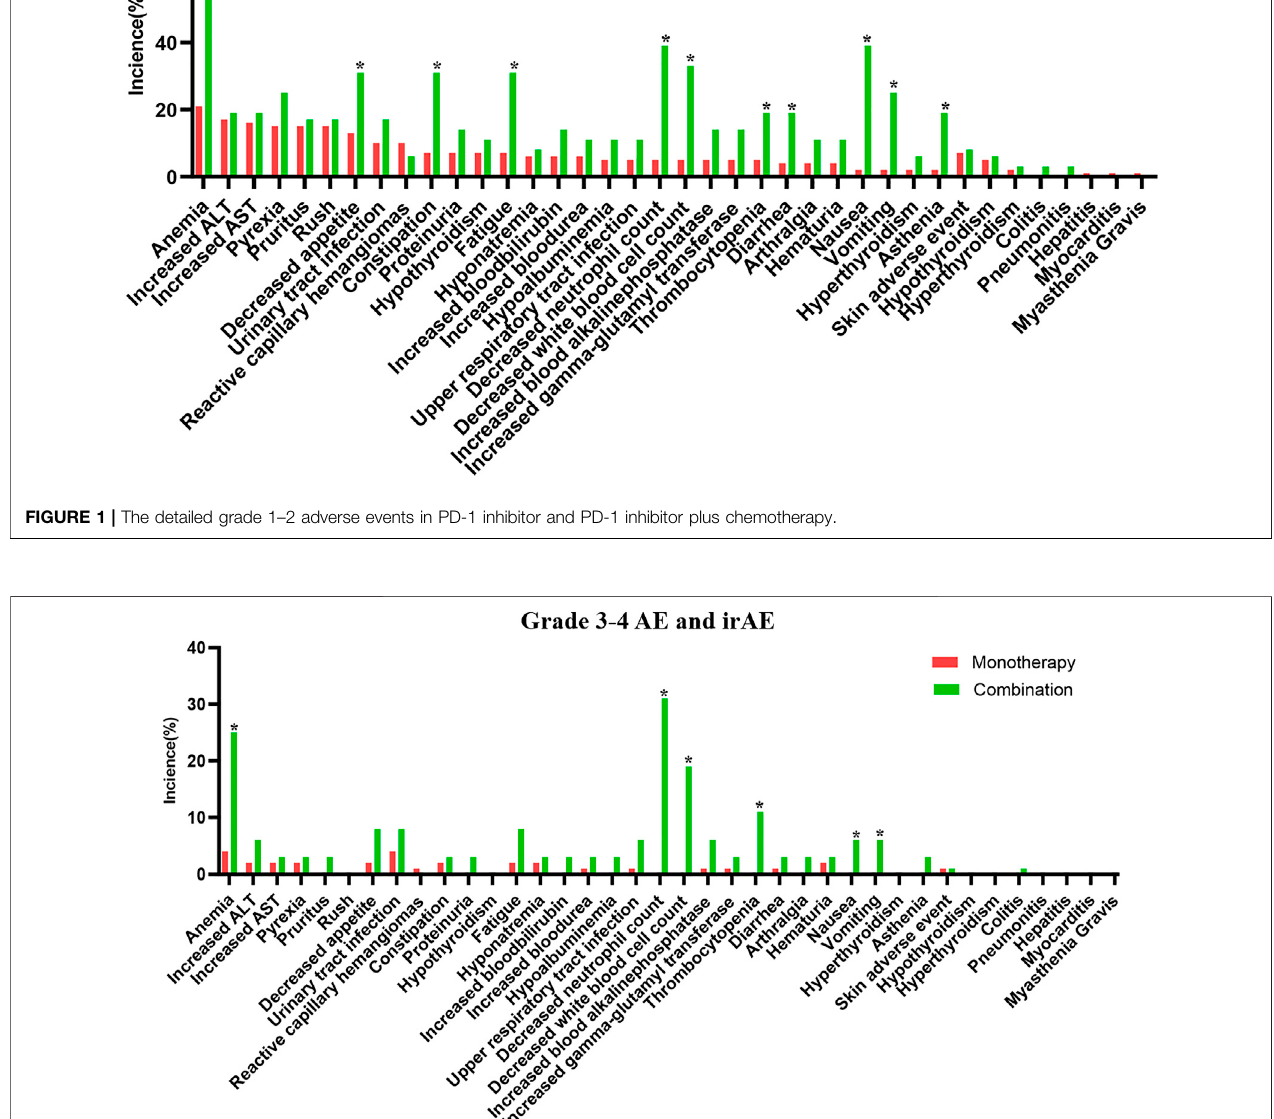
Frontiers in Pharmacology |